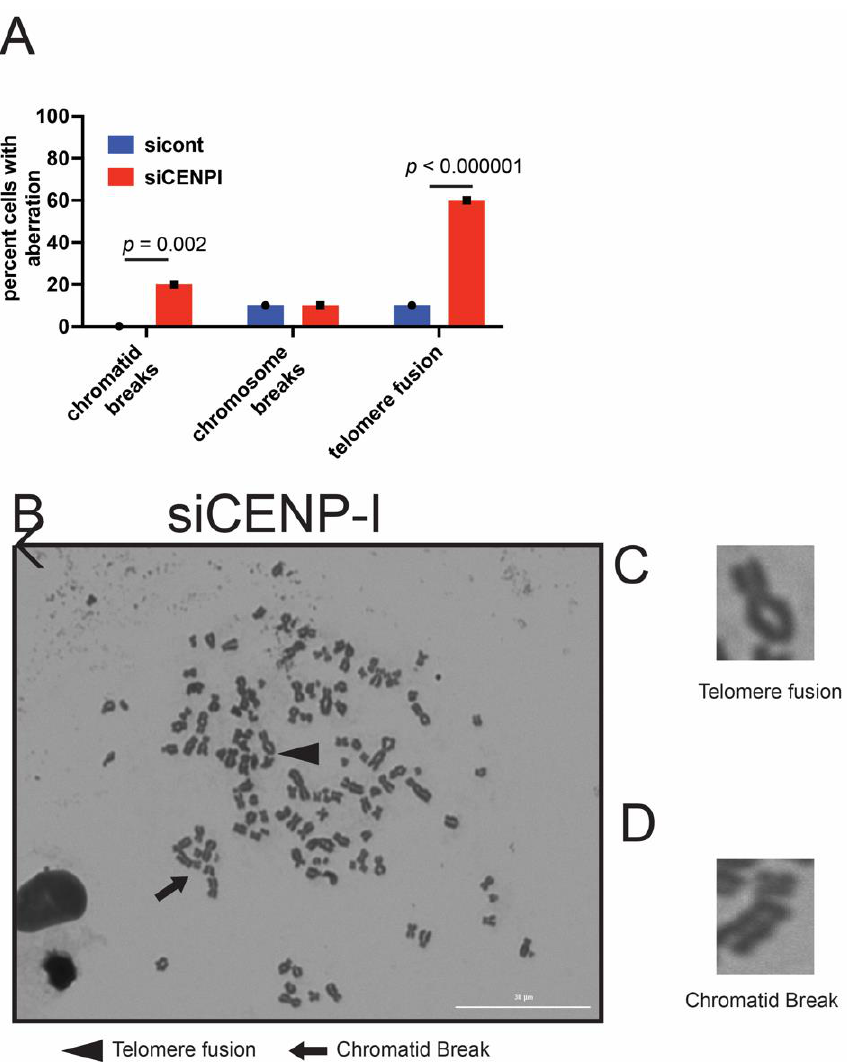
Figure 4. Loss of CENP-I results in increased chromatid breaks and telomere fusions. ( A – D ) Chro- matid breaks and telomere fusions were visualized and quantitated using CENP-I-deficient and proficient cells using metaphase spreads. Statistical analysis was performed using S tudent’s t -test.